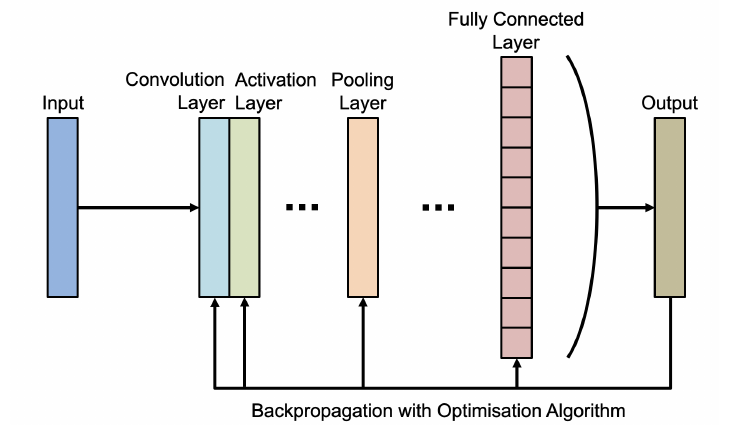
Figure 1. Basic structure of a typical Convolutional Neural Network (CNN).